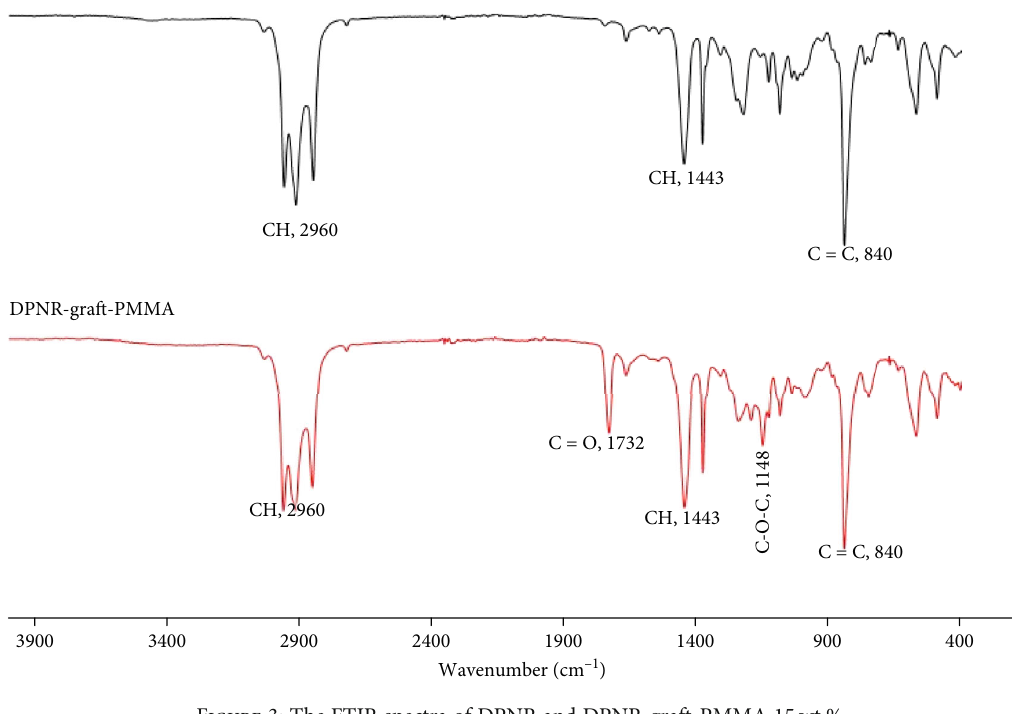
Figure 3: The FTIR spectra of DPNR and DPNR-graft-PMMA 15 wt.%.